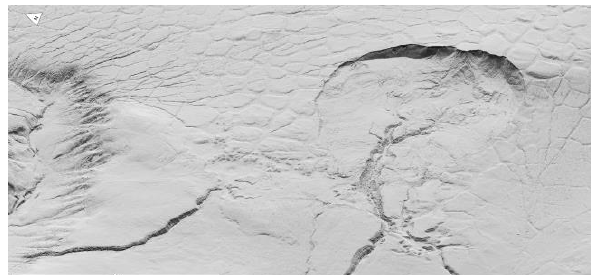
Figure 8. Triangulated, shaded surface model of the thaw slump area reveals micro topography of the landforms. Polygon constrained water flow patterns can also be seen in the top left of the image running towards a larger channel.